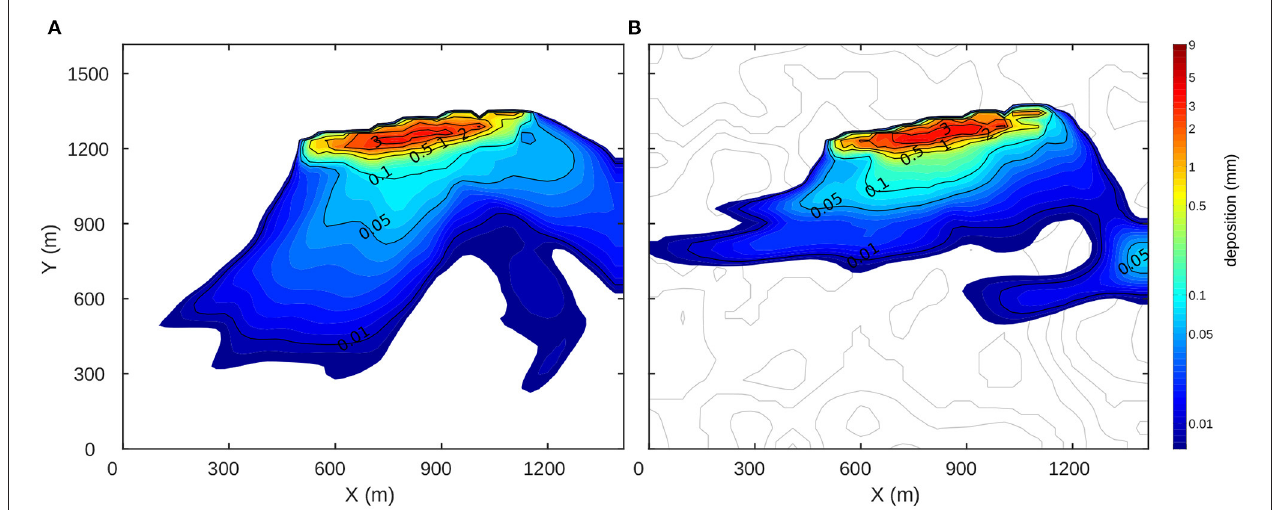
FIGURE 10 | Numerical simulation of the deposition pattern for (A) a flat seabed and (B) higher release height above the sea